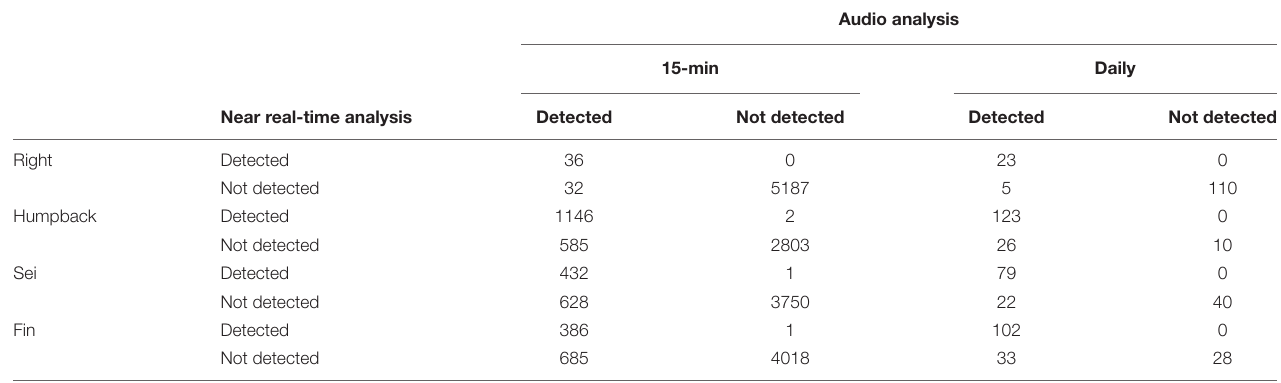
TABLE 1 | Confusion matrices comparing near real-time analysis to audio analysis for right, humpback, sei, and fin whales over 15-min and daily time scales.